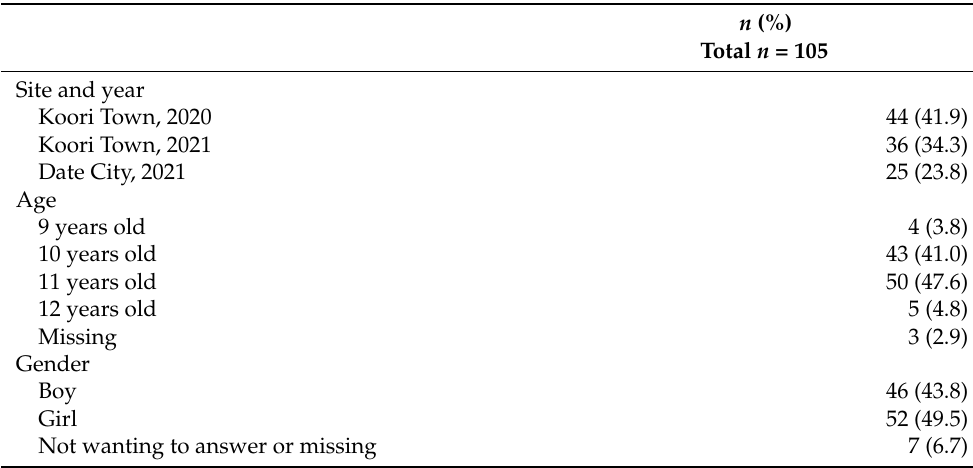
Table 1. Characteristics of participating students.